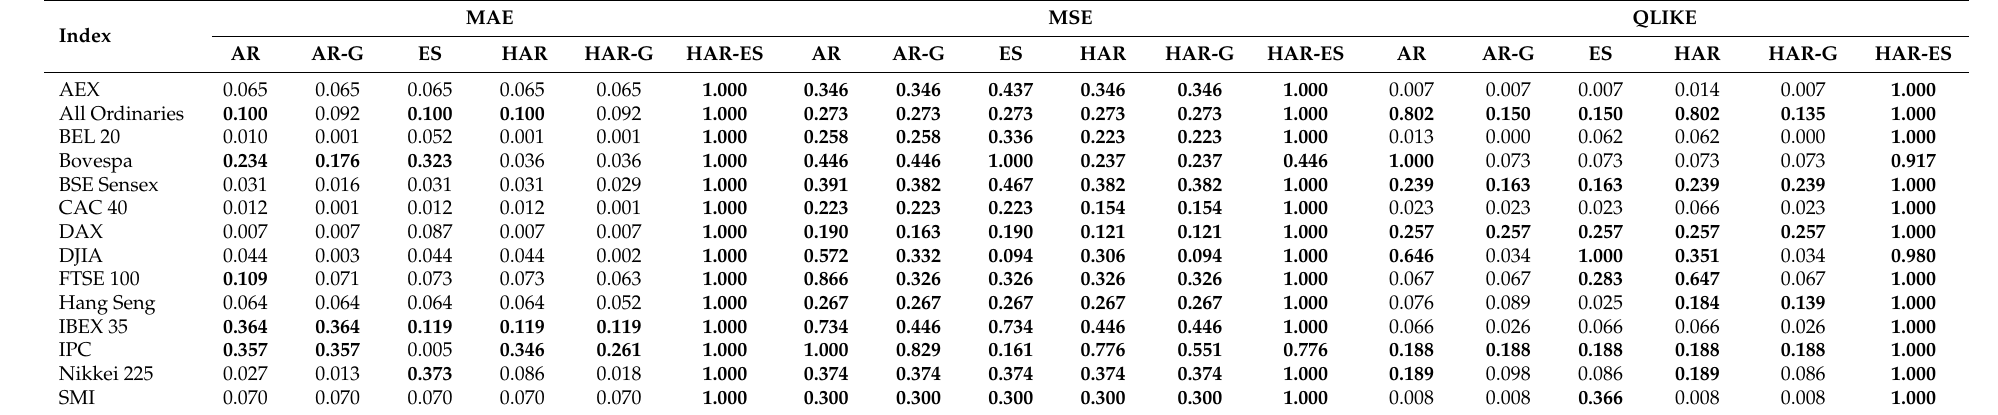
Table 8. Model Confidence Set p